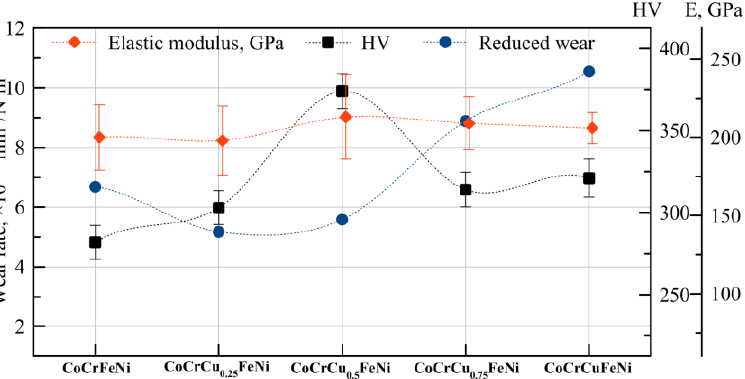
Figure 6. The effect of copper on hardness (HV), the elastic modulus (E, GPa), and wear of CoCrCu x FeNi.